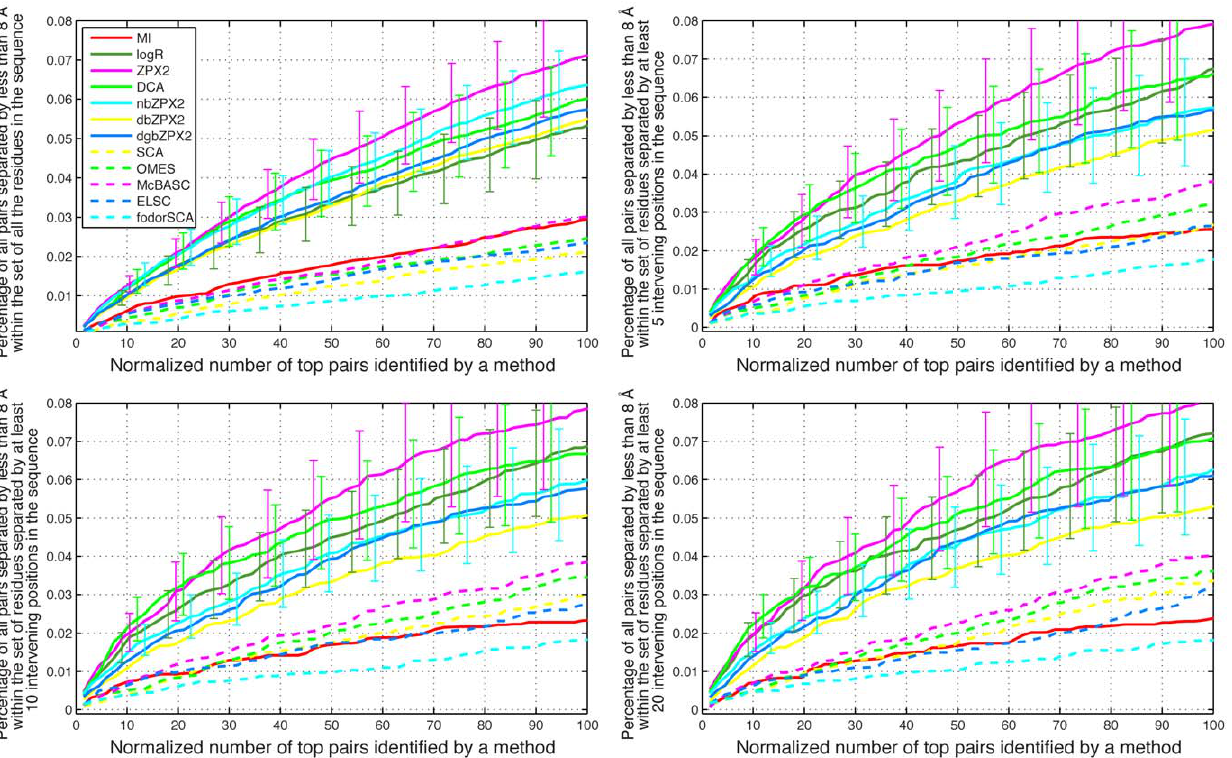
Figure 5. Averaged results for 8 protein families with experimental MSAs under 500 sequences. Each panel shows the percentage in the top coevolving pairs identified by each method, among the residue pairs separated by less than 8 A˚ in the X-ray structure of each protein. The abscissa scale is normalized in such a way that 100 corresponds to a number of pairs equal to the number of residues in the sequence. In the top left panel all protein pairs are considered, including those represented by consecutive residues in the sequence. In the top right panel only pairs whose residues are separated by at least 5 intervening positions in sequence space are considered. In the bottom left and bottom right panels only pairs whose residues are separated by at least 10 and 20 intervening positions in sequence space are